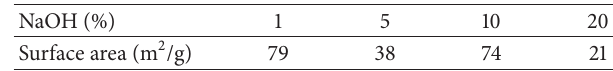
Table 4: Effect of NaOH concentration on the surface area of aluminium dross at reaction time of 15 minutes and temperature at 25 ∘